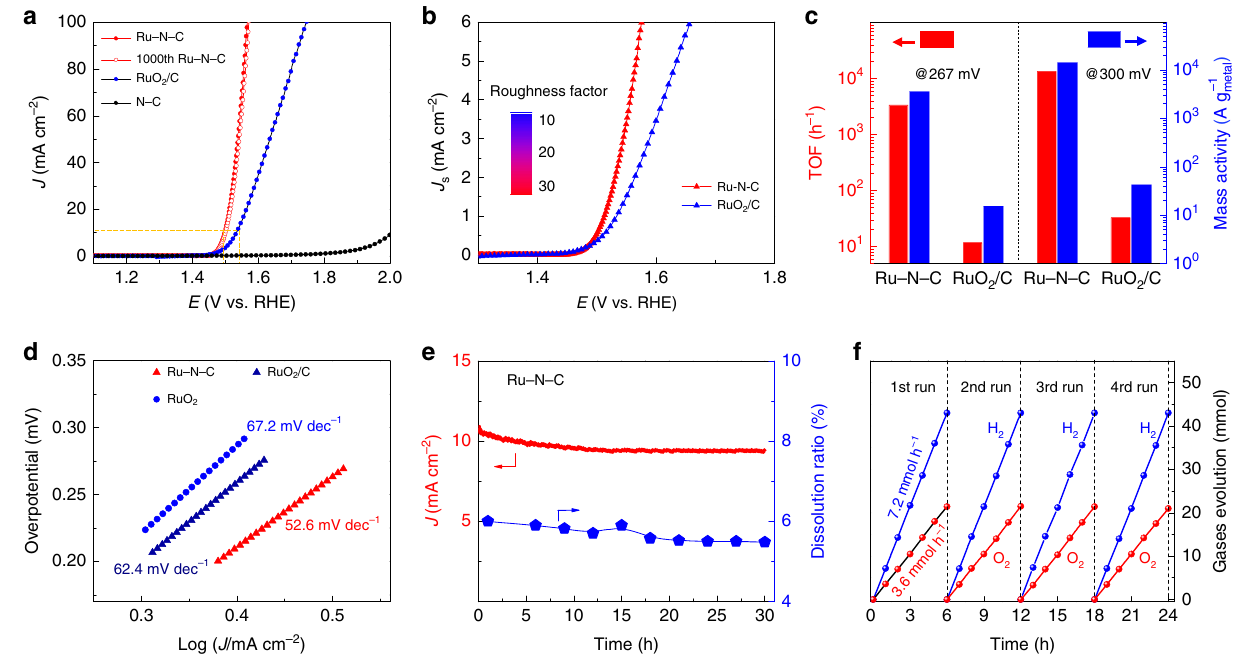
Fig. 2 Electrochemical OER properties. a Electrocatalytic OER performances of the Ru-N-C and commercial RuO 2 /C in 0.5 M H 2 SO 4 electrolyte. b Normalized linear sweep voltammetry curves to electrochemically active surface area. c TOF and mass activities for Ru-N-C and RuO 2 /C electrocatalysts. d Tafel slopes for Ru-N-C and RuO 2 /C electrocatalysts. e Plot of current density and Ru dissolved mass ratio versus time for Ru-N-C at a constant anode voltage of 1.49 V versus RHE in 0.5 M H 2 SO 4 electrolyte. f Time pro fi les of O 2 and H 2 evolutions in overall water splitting. All potentials